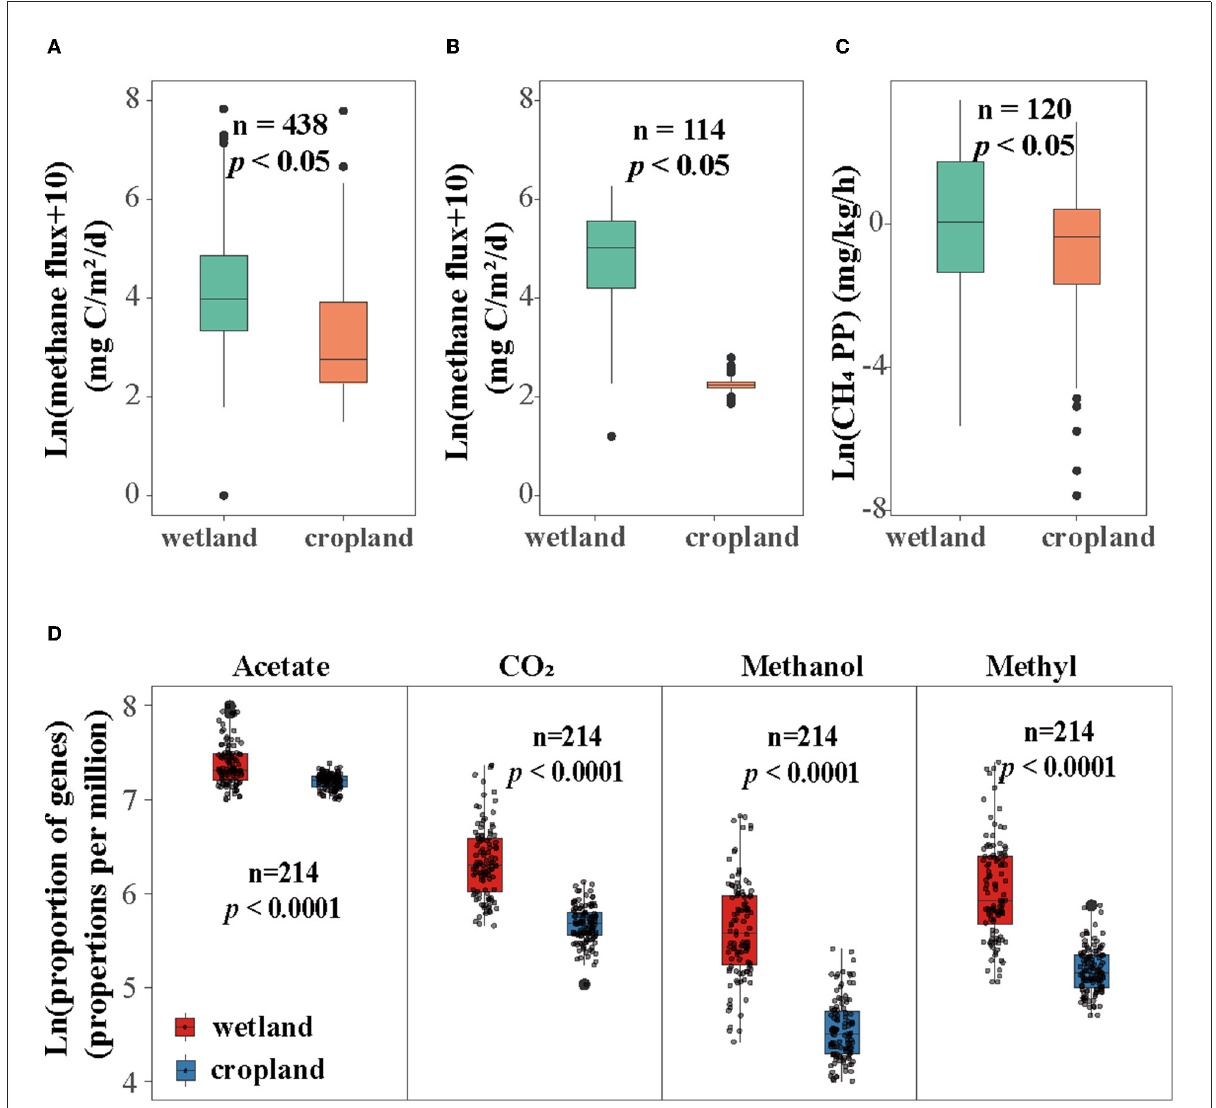
FIGURE1 Influence of cultivation on methane flux in (A) global scale, (B) local scale, (C) methane production potential (CH 4 PP), and proportion of genes in four methane production pathways. (D) Relative abundance of four pathways including acetate pathway, CO 2 pathway, methanol pathway, and methylamines (short for methyl) pathway. The proportion of four pathways was the relative abundance of functional genes involved in four pathways calculated as parts per million (ppm) and then log-transformed.